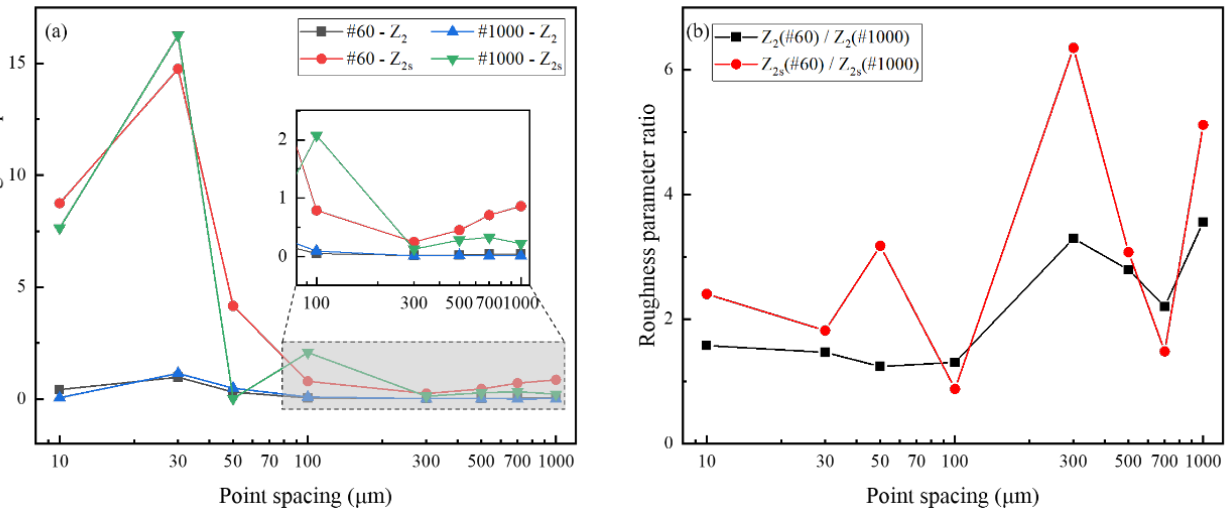
Figure 5. Roughness parameter calculation results. ( a ) Standard deviation of roughness parameters calculated by taking into account points with different point spacings for three groups of contour lines. ( b ) Ratio of average values of different roughness parameters of fault surfaces which were roughened with #60 and #1000 sandpapers.